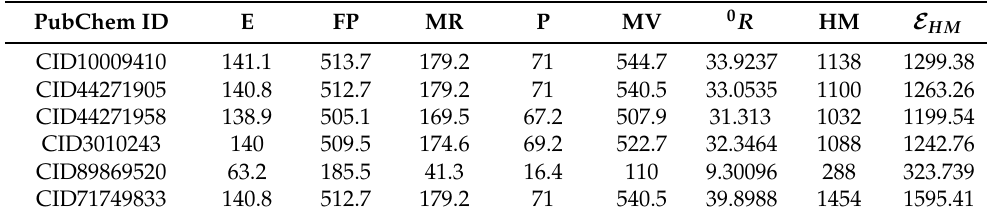
Table 1. The physicochemical properties of potential drugs which can be a treatment of COVID-19 and their corresponding topological indices.